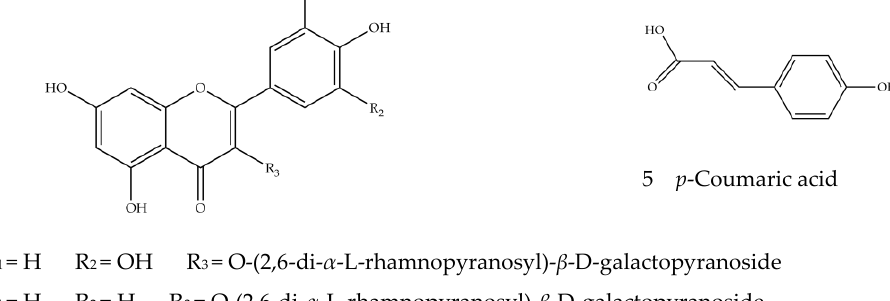
Figure 2. Total ion flow diagram of chemical constituents in quinoa husk extracts in negative ion mode by LC-MS.